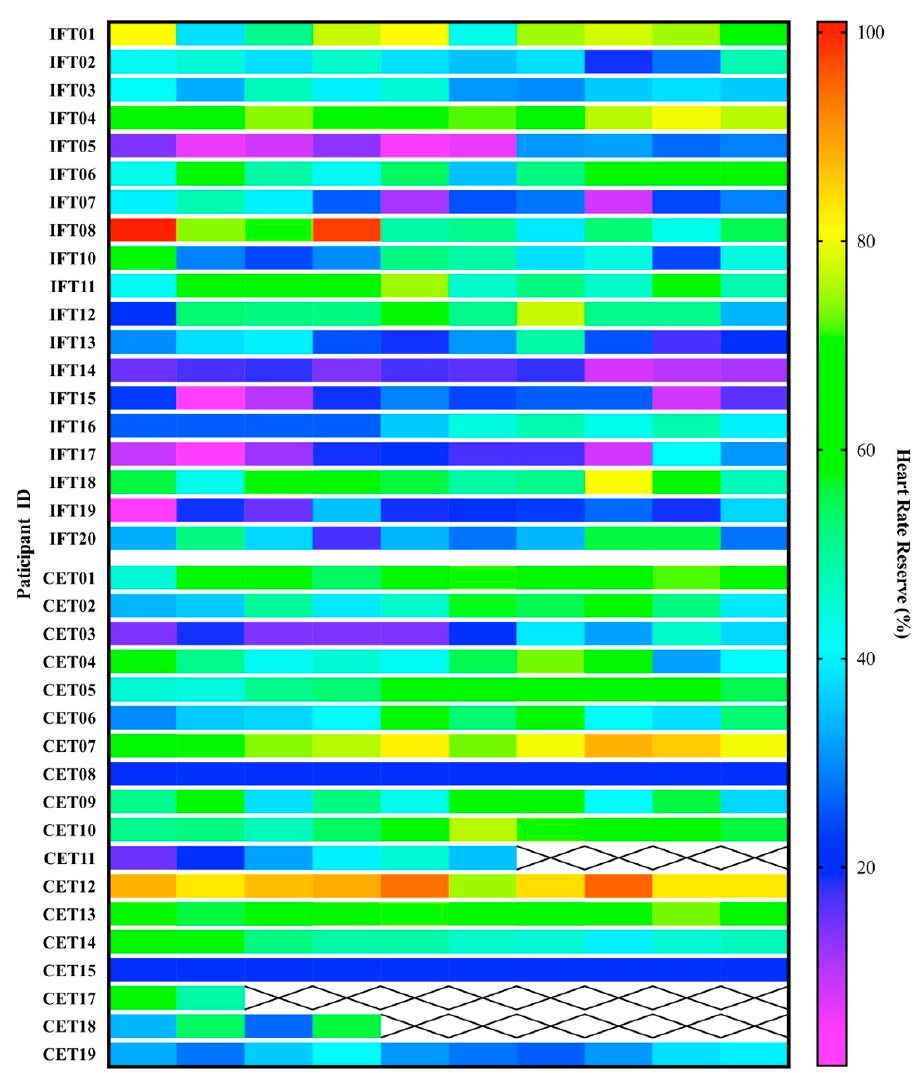
Figure 2. Dose analysis. Heatmap displaying participant’s average heart rate during each week of aerobic exercise training. The graph’s top and bottom halves are separated for intermittent functional training (IFT) and constant-load ergometer training groups (CET), respectively. Dark blue and purple cells indicate workloads below the moderate-intensity aerobic exercise threshold (i.e., <40% HRR).